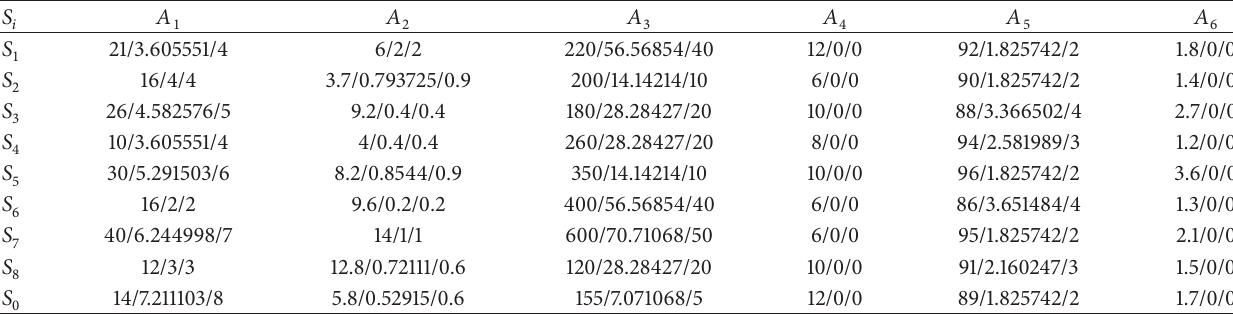
Table 2: Average values, standard deviations, and maximum deviations of all indices.